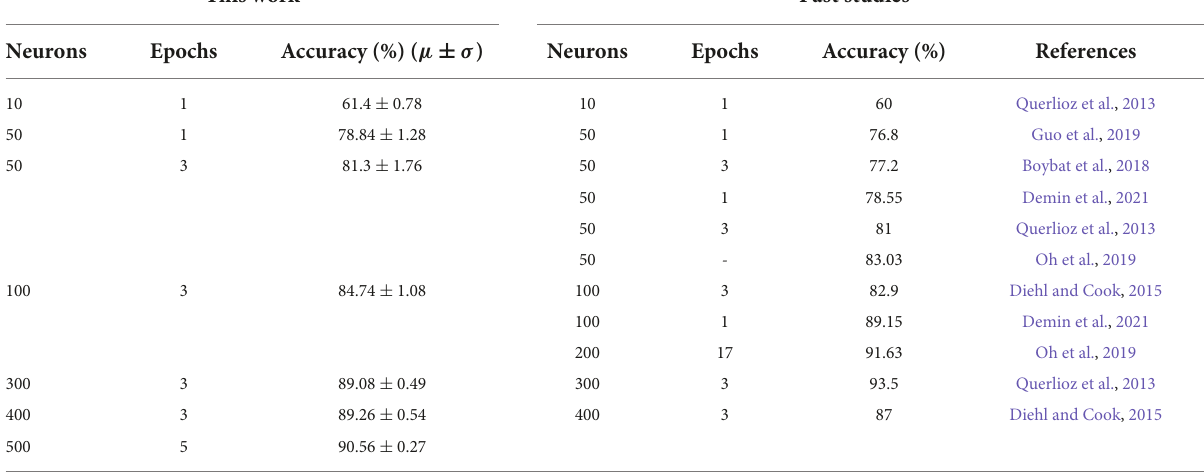
TABLE 2 State-of-the-art accuracy obtained with the STDP learning rule is tabulated for different numbers of epochs and output neurons. This work Past studies